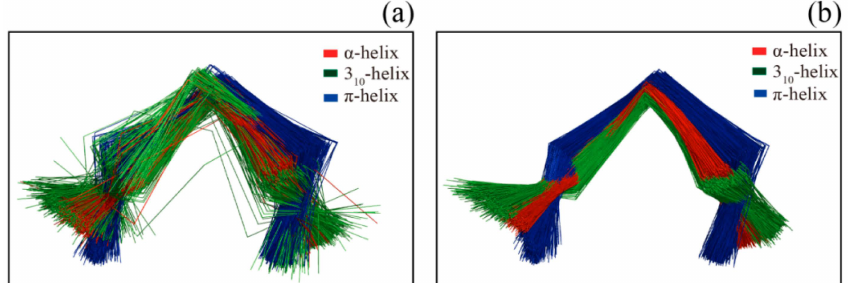
Figure 3. The 5-residue-long fragments assigned by DSSP ( a ) and SACF ( b ). Three helix elements ( α -helix, 310-helix and π -helix) are involved in the figure. We randomly selected 1000 fragments for the three helix elements assigned by DSSP ( a ) and SACF ( b ). As can be seen, the three helix elements assigned by SACF can be better separated compared with DSSP